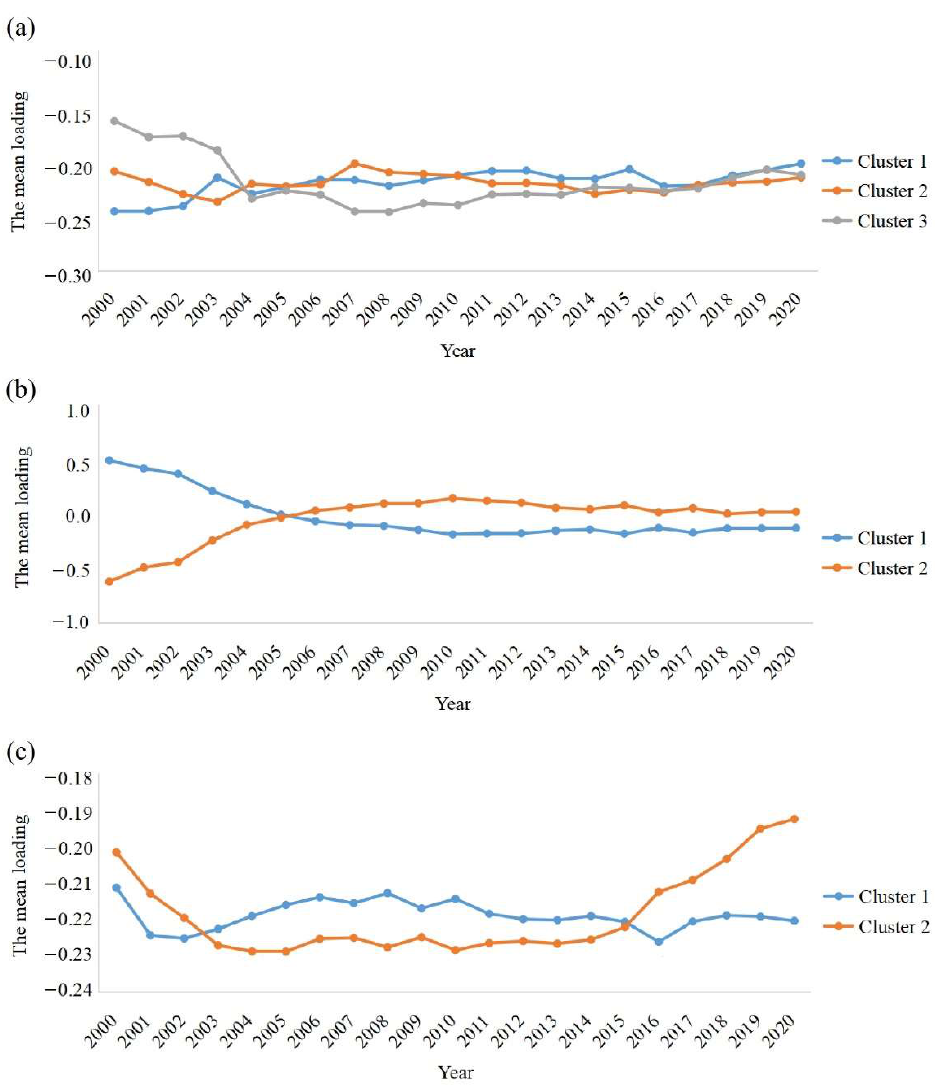
Figure 8. The mean values of GWPCA loading of clusters. ( a ) small livestock GWPC1; ( b ) small livestock GWPC2; ( c ) large livestock GWPC1. Table 2. Occurrence of meteorological disasters for each cluster of small and large livestock. Small Livestock GWPC1 Small Livestock GWPC2 Large Livestock